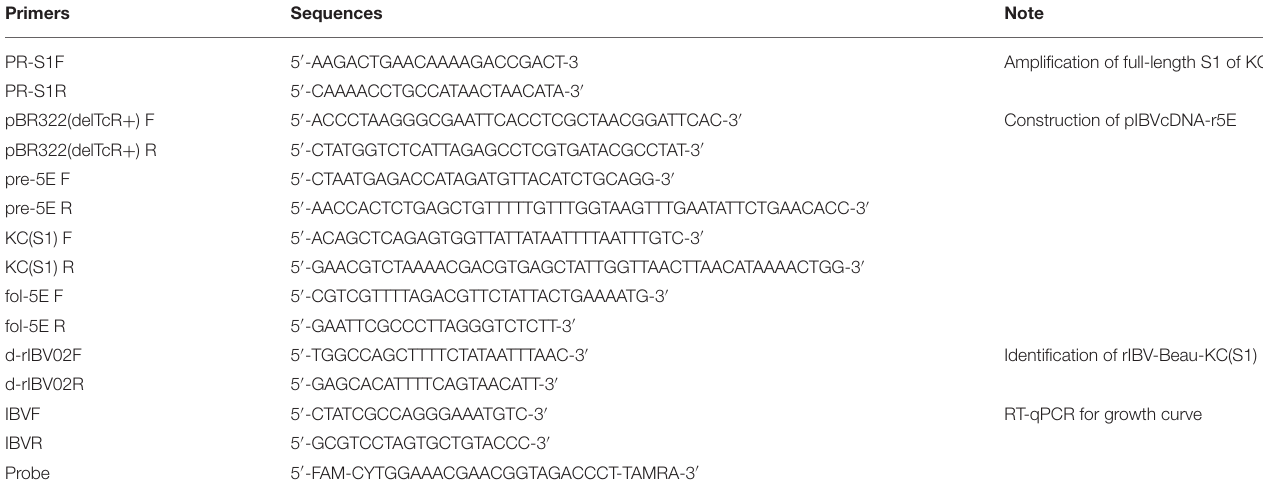
TABLE 1 | Primers for construction of pIBVcDNA-r5E plasmid and RT-qPCR.